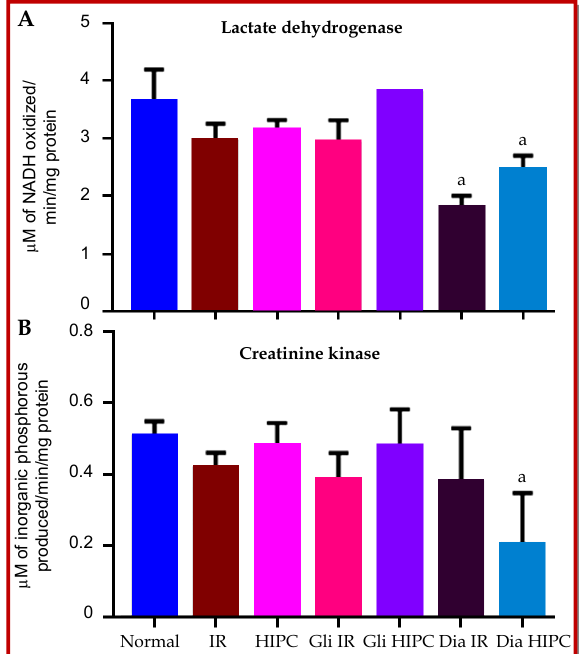
Figure 1: Effect of hydrogen sulfide on ischemia reperfusion- induced myocardial injury: hydrogen sulfide preconditioning effect on cardiac injury markers across the groups was repre- sented by the activities of (A) lactate dehydrogenase and (B) creatine kinase. Values were expressed as mean ± SD of n=6 rats/group. a statistically significant from normal perfusion (p<0.05)